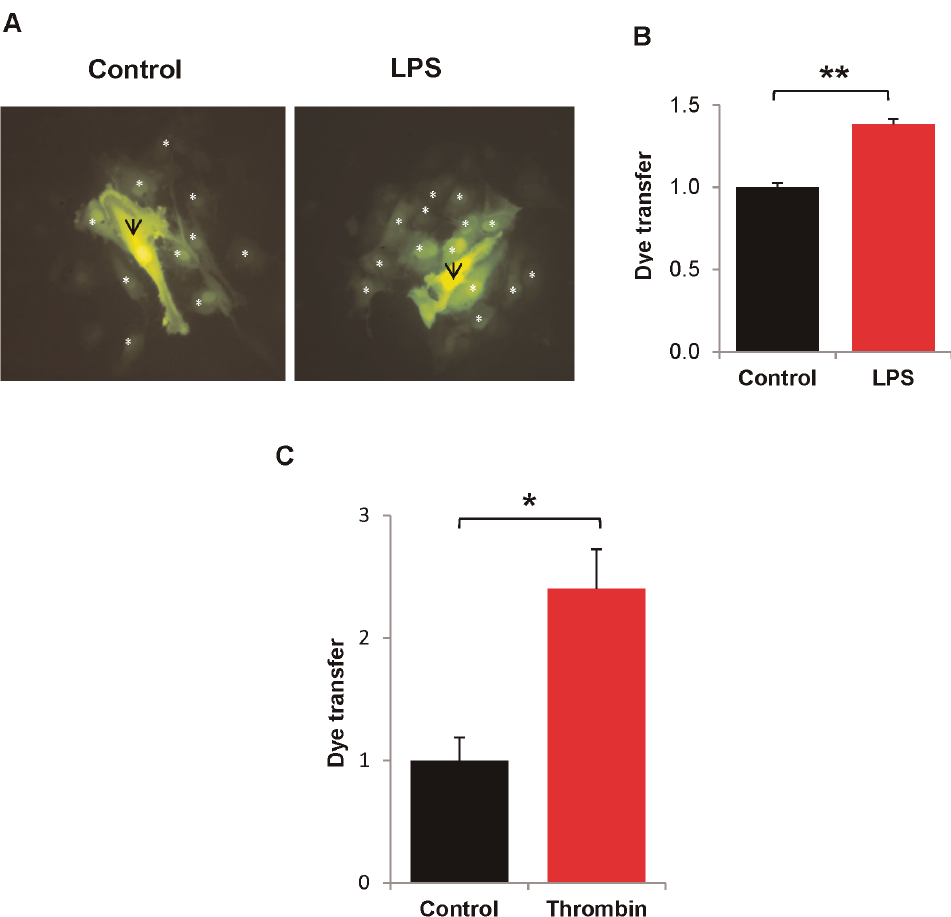
Figure 4. LPS and chronic thrombin treatments increase intercellular communication. HPAECs were grown to confluence on glass cover slips and treated with LPS (200 ng/mL for 24 hr) or chronic thrombin (0.25 U/mL; once every hr for 6 hr.) Single cells were injected with Lucifer yellow for 1 min., and cells were photographed after an additional 5 min. A.) Photomicrographs show representative fluorescence images of an injected cell and its neighbors after injection of Lucifer yellow in a control culture or a culture treated with LPS. The injected cell is marked with a black arrow; neighboring cells which show dye transfer are marked with a white asterisk. B.) Graph shows the composite data for Lucifer yellow dye transfer in control or LPS-treated HPAECs. Values shown are normalized by dividing the number of dye-containing neighbors by the average value obtained by injections in control cultures. **, p , 0.001. n=4. C.) Graph shows the composite normalized data for Lucifer yellow dye transfer in control or thrombin-treated HPAECs. *, p , 0.05,